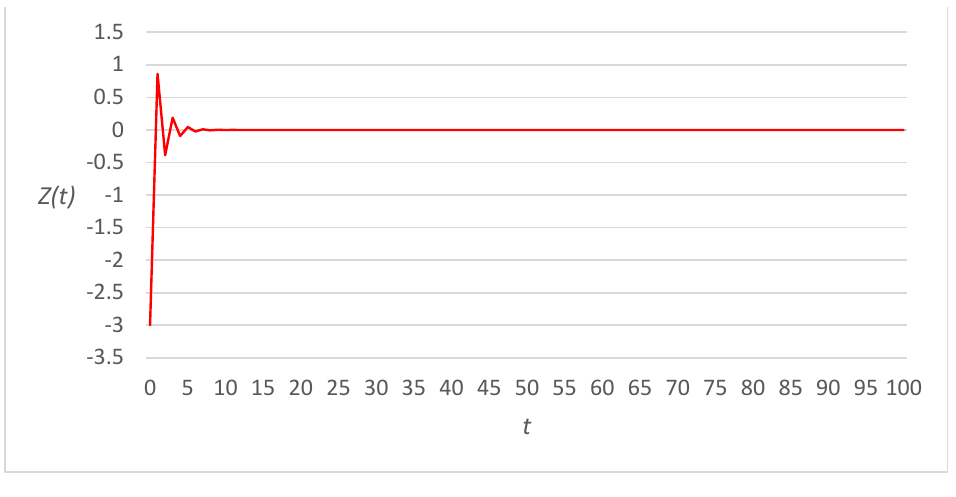
Figure 11. Time evolution of dynamical system for 𝛼 = 0.9; 𝛽 = 0.9; 𝛾𝜇 = 5; 𝜑 = 0.15; 𝑍(0) = −3 (case of fourth-power link cost functions).